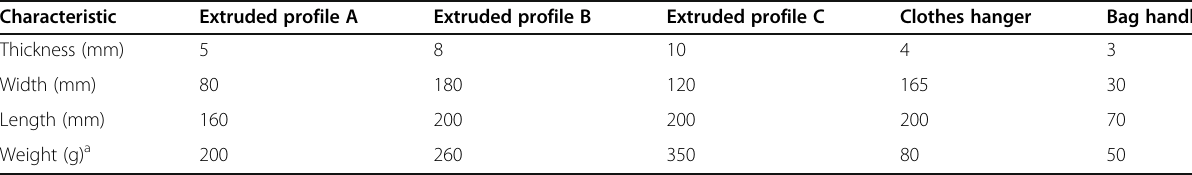
Table 6 Physical characteristics of products obtained using eco-composites